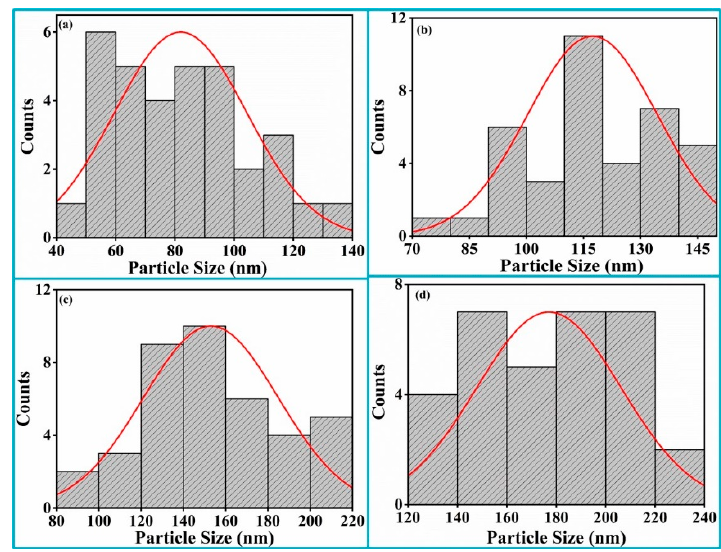
Figure 9. Histograms for particle size distribution and Gaussian fitting curves of the Bi 2 O 3 :Ho 3+ thin films deposited in the different oxygen partial pressures: ( a ) 5 mT, ( b ) 20 mT ( c ) 100 mT and ( d ) 200 mT.